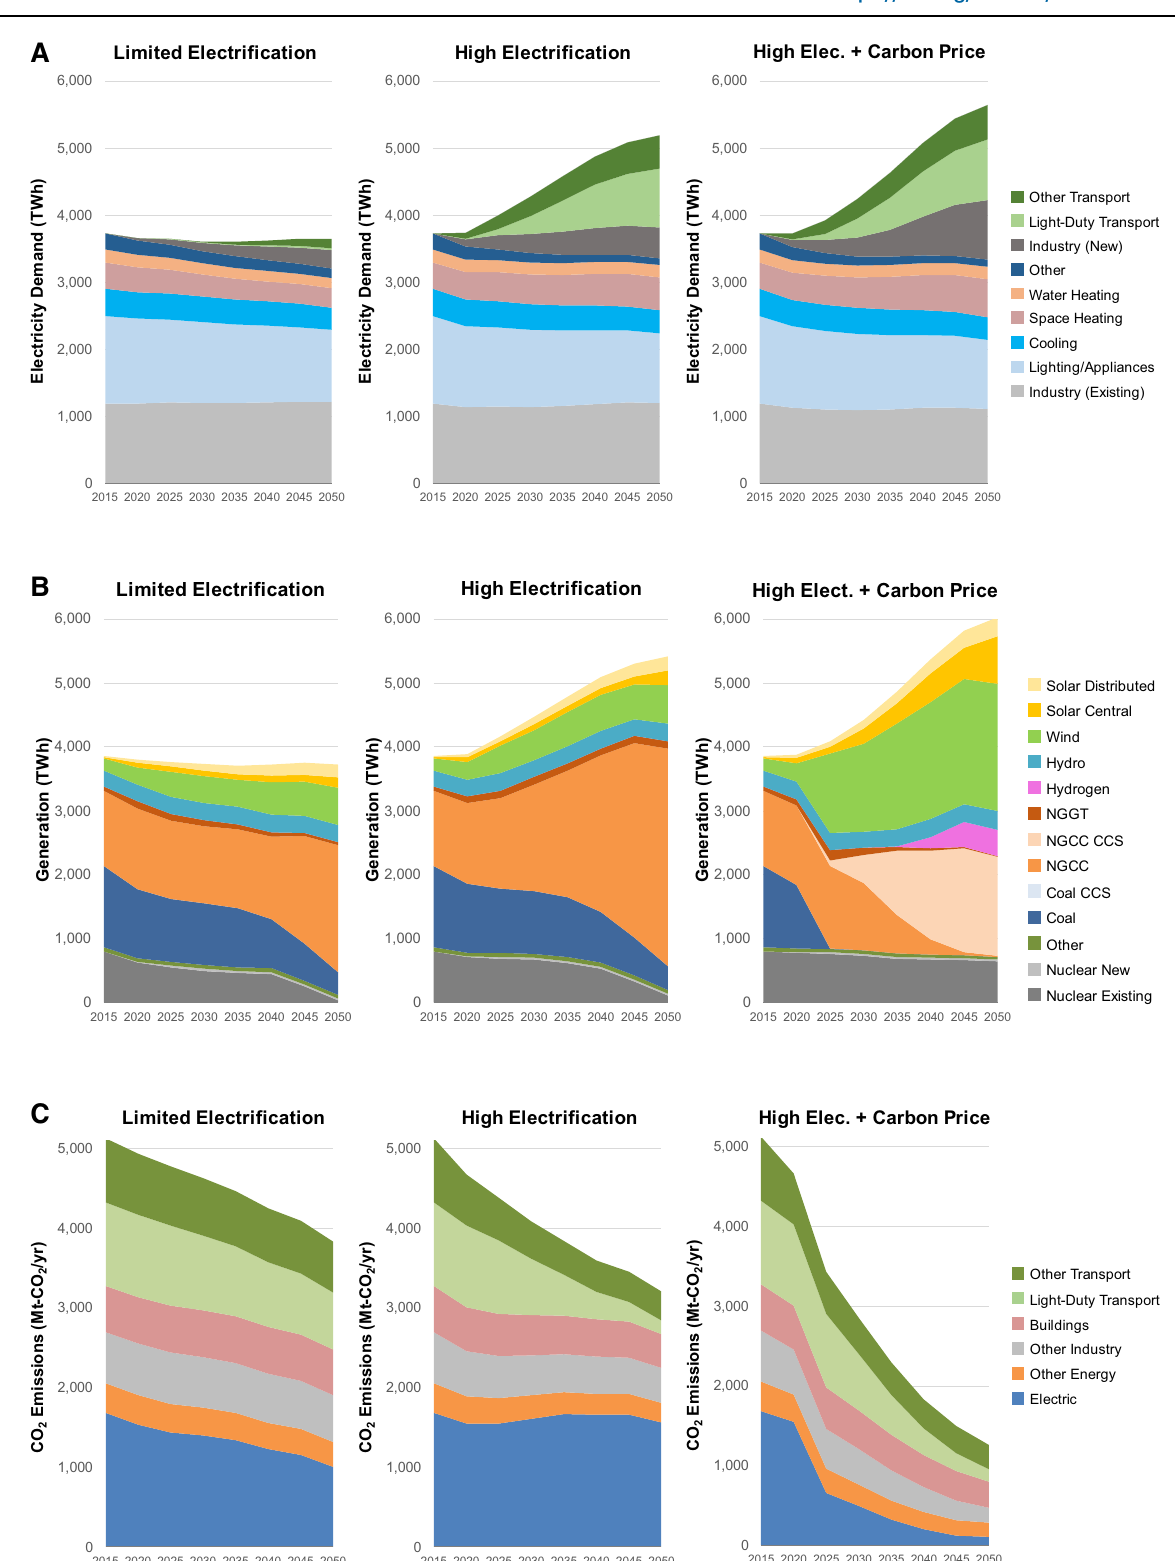
Fig. 1 | Electricity demand, generation, and economy-wide CO 2 emissions across the three electri fi cation and policy scenarios. A Electricity demand by end use over time with newly electri fi ed loads at the top. B Generation by tech- nologyover time (where NGGT are naturalgasturbines, NGCC are combined cycle units, and CCS are gas- fi red units with carbon capture and storage). C CO 2